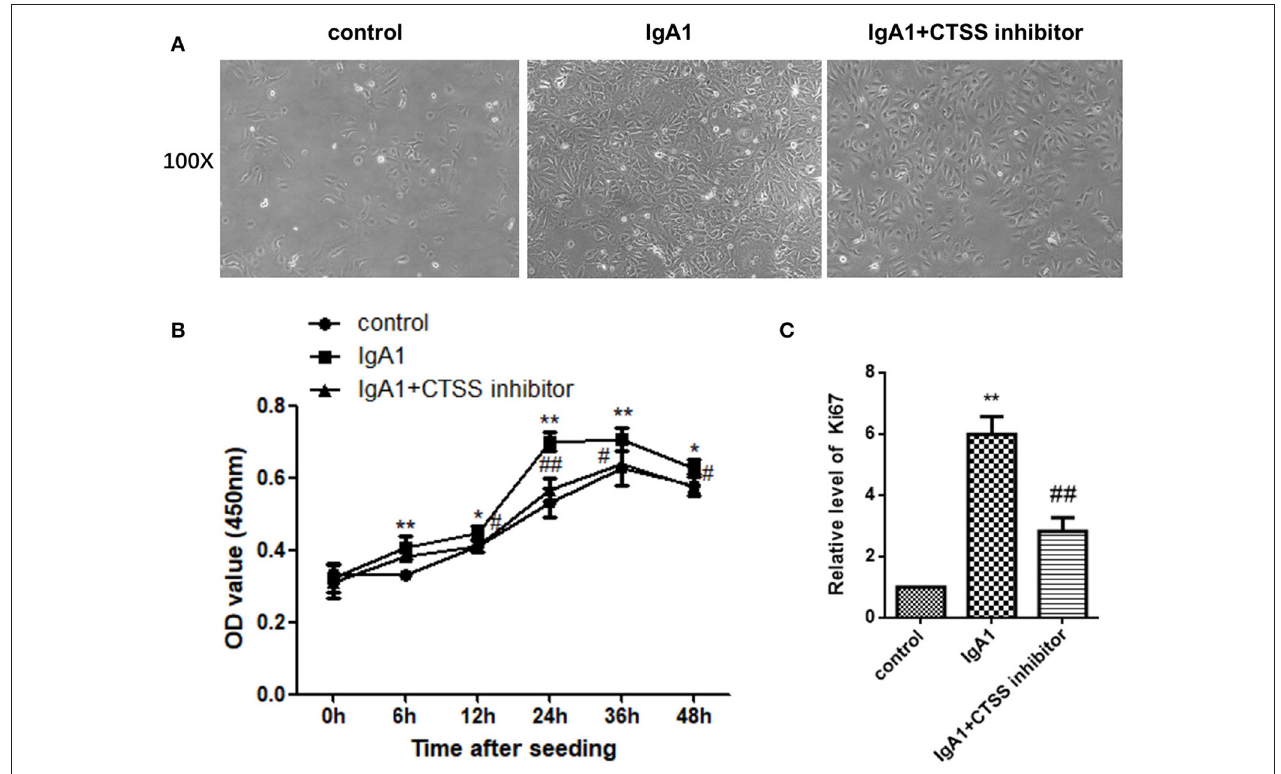
FIGURE 5 | Treatment with the CTSS inhibitor mitigates the IgA1-stimulated the proliferation of HMCs in vitro . HMCs were pre-treated with vehicle or the CTSS inhibitor overnight and stimulated with, or without, IgA1 for the indicated time periods. Their morphology was observed under a light microscope and their cell viability was determined by CCK-8 assay. The relative levels of Ki67 to GAPDH mRNA transcripts were examined by qRT-PCR. Data are representative images or expressed as the means ± SD of each group from three separate experiments. (A) Morphological changes of cells. (B) CCK-8 analysis of cell viability. (C) Quantitative RT-PCR analysis of Ki67 mRNA transcripts in the cells. * P < 0.05, ** P < 0.01 vs. the Controls; # P < 0.05, ## P < 0.01 vs. the cells without the CTSS